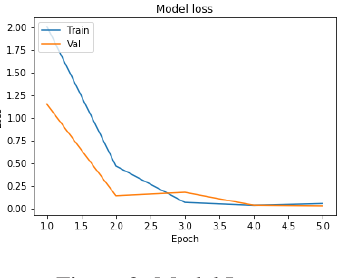
Figure 1: Architecture of Deep